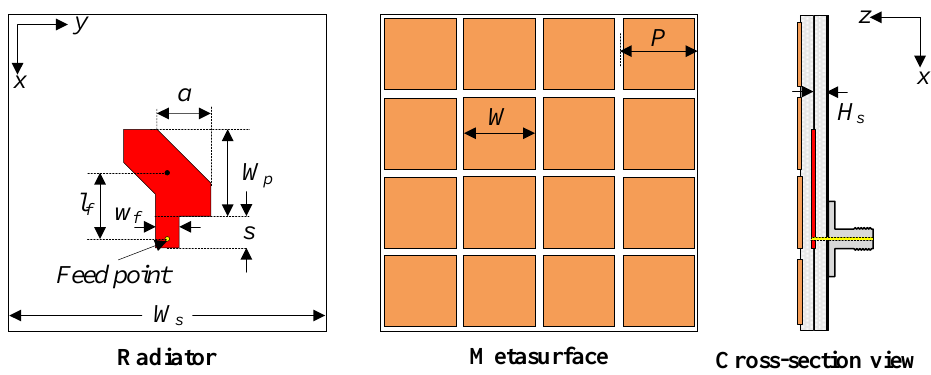
Figure 1. Geometry of single wideband MS based antenna. The optimal antenna’s dimensions are: W s = 40 mm, H s = 1.52 mm, W p = 13 mm, a = 7 mm, l f = 8.5 mm, w f = 3 mm, s = 4 mm, P = 8 mm, W = 7.5 mm.